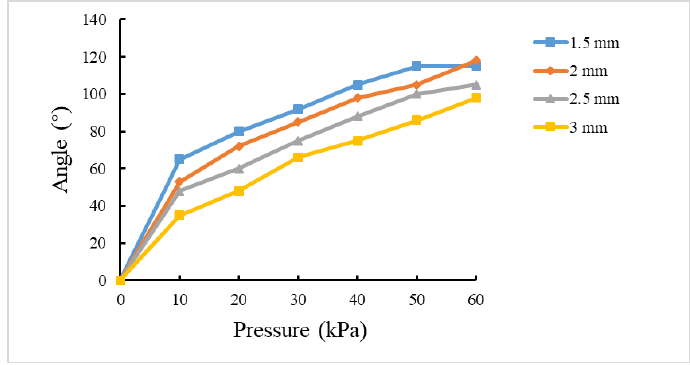
Figure 6. Effect of constraint layer thickness on bending properties.